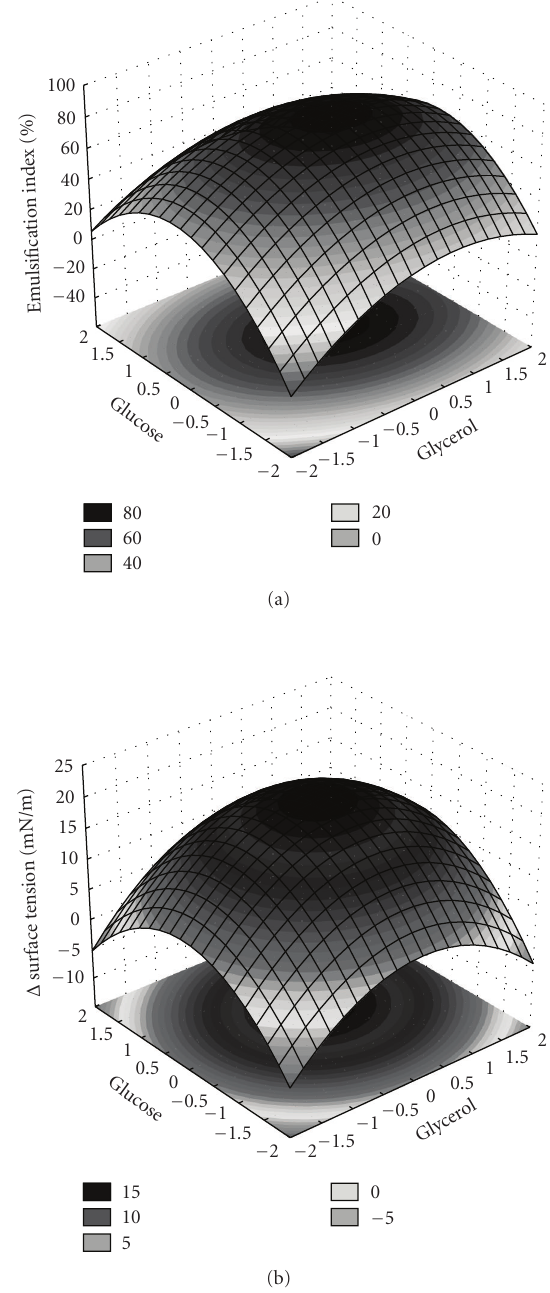
Figure 5: Three-dimensional response surface showing the e ff ect of glucose and glycerol on variation of emulsification index (a) and surface tension